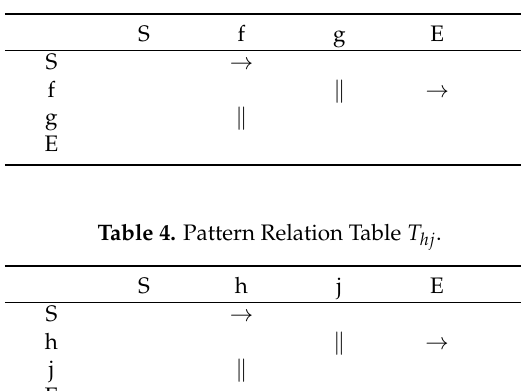
Table 3. Pattern Relation Table T fg .